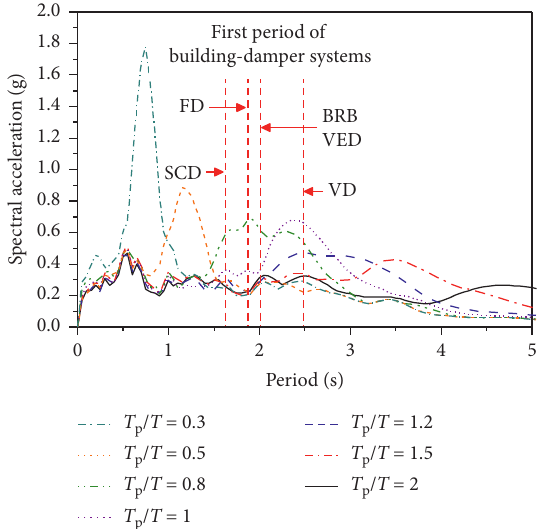
Figure 20: Acceleration spectra of ANEs with different pulse periods.